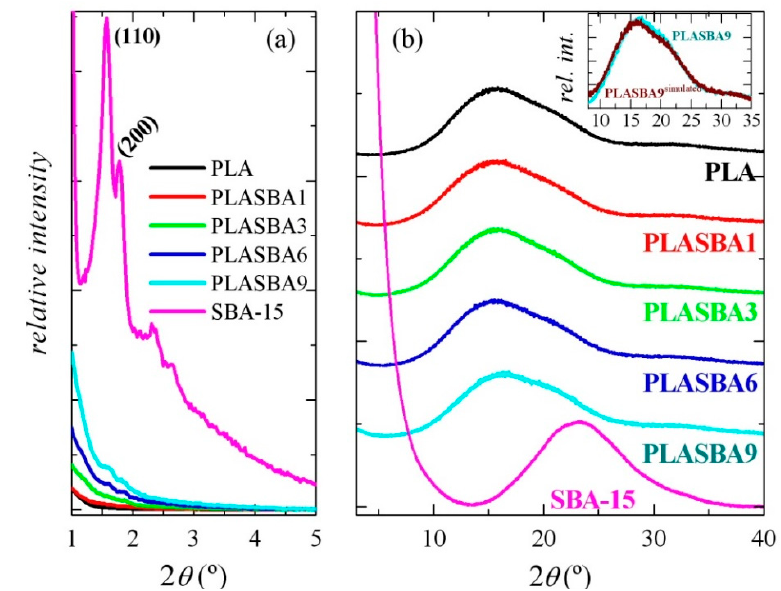
Figure 2. X-ray diffraction patterns at room temperature for pristine PLA, mesoporous SBA-15 particles, and the different composites based on PLA and distinct SBA-15 contents at middle ( a ) and wide angles ( b ). Inset: comparison between the experimental and simulated patterns (see text) for PLA-SBA9.